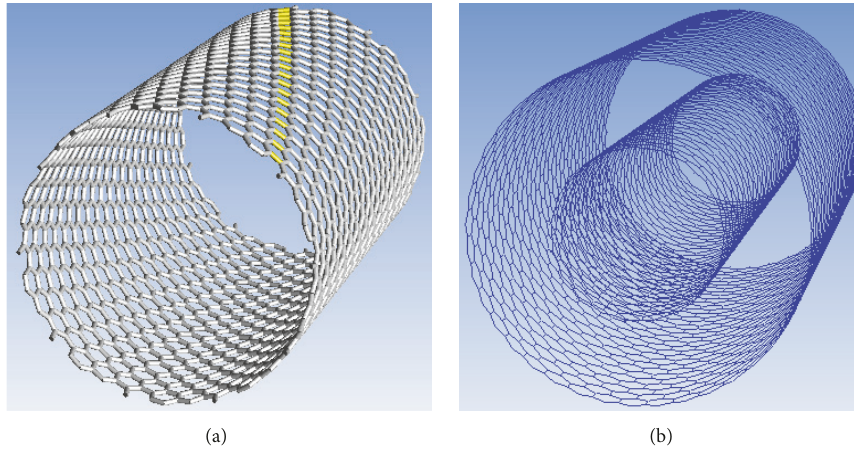
Figure 23: Modeling for carbon nanotube.